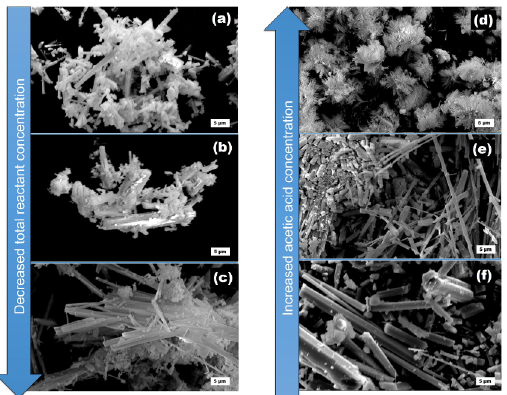
= 544 nm) and Figure 6. Solid-state excitation (dashed line, λ em emission (solid line, λ = 295 nm) spectra of prepared MLOF ex samples measured at room